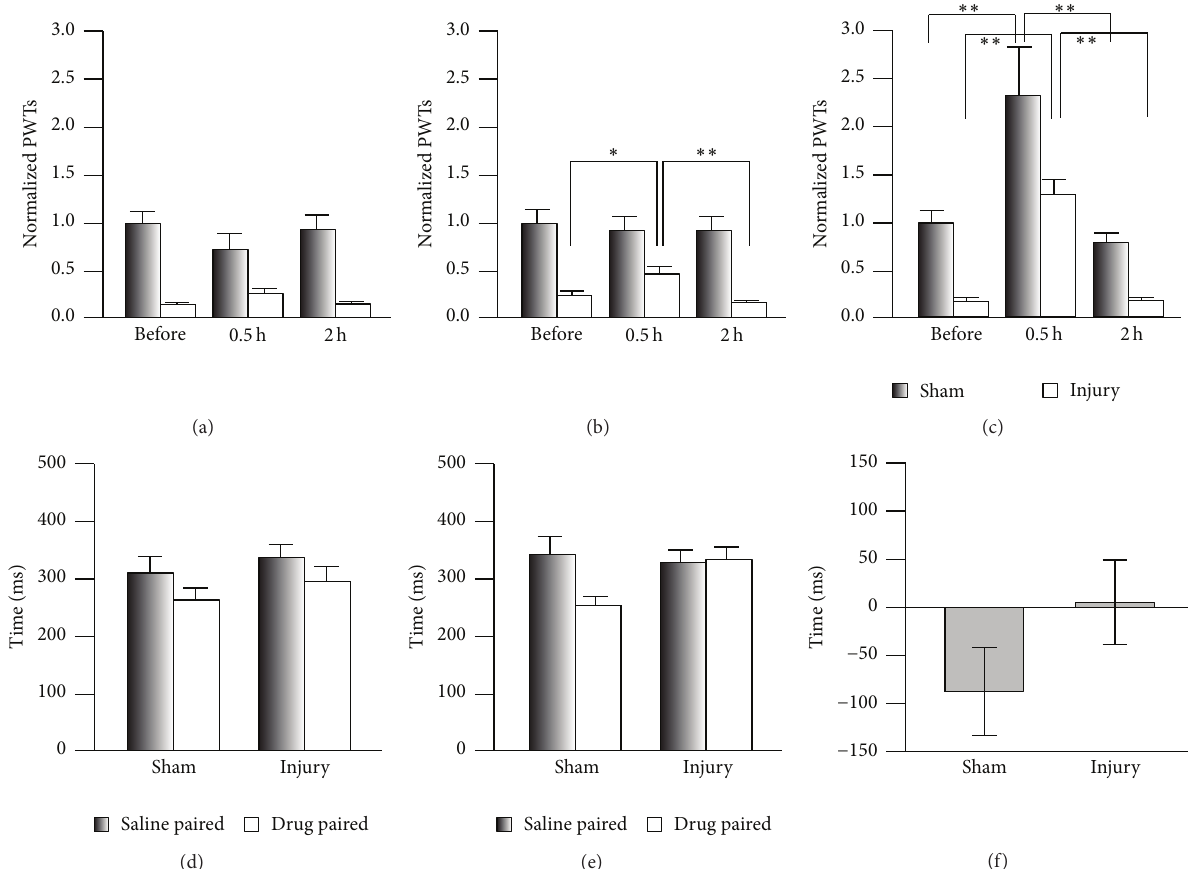
Figure 3: Application of ambenonium chloride had no effect on spontaneous pain. (a) Ambenonium at 0.01mg/kg had no effect on the PWTs of the sham and nerve-injury groups (two-way RM ANOVA, sham versus injury: 𝐹 1;35 = 30.45 , 𝑃 < 0.01 ; treatments: 𝐹 2;35 = 0.59 , 𝑃 > 0.05 , 𝑛 = 6 per group). (b) Ambenonium at 0.05 mg/kg increased the PWTs of the nerve-injury group (two-way RM ANOVA, sham versus injury: = 27.52 , 𝑃 < 0.01 ; treatments: 𝐹 = 2.94 , 𝑃 > 0.05 , 𝑛 = 6 for sham, 𝑛 = 8 for injury; ∗ 𝑃 < 0.05 and ∗∗ 𝑃 < 0.01 under SNK test). (c) 𝐹 1;41 2;41 Increasing the dose of ambenonium to 0.1mg/kg raised the PWTs in both groups (two-way RM ANOVA, sham versus injury: 𝐹 1;32 = 28.57 , = 22.42 , 𝑃 < 0.01 , ∗∗ 𝑃 < 0.01 under Tukey’s test). (d) Time spent in the chambers during the CPP preconditioning 𝑃 < 0.01 ; treatments: 𝐹 2;32 period (two-way RM ANOVA, sham versus injury: 𝐹 1;43 = 4.21 , 𝑃 > 0.05 ; saline versus drug: 𝐹 1;43 = 1.76 , 𝑃 > 0.05 , 𝑛 = 9 for sham group, 𝑛 = 13 for injury group). (e) Ambenonium at 0.05 mg/kg did not induce preference for the drug-paired chamber in the CPP test (two-way RM ANOVA, sham versus injury: 𝐹 1;43 = 11.57 , 𝑃 < 0.05 ; saline versus drug: 𝐹 1;43 = 1.61 , 𝑃 > 0.05 , 𝑛 = 9 for sham group, 𝑛 = 13 for injury group). (f) No difference in the preference time induced by ambenonium at 0.05 mg/kg was detected in the CPP test ( t -test, 𝑃 > 0.05 , 𝑛 = 9 for sham group, 𝑛 = 13 for injury